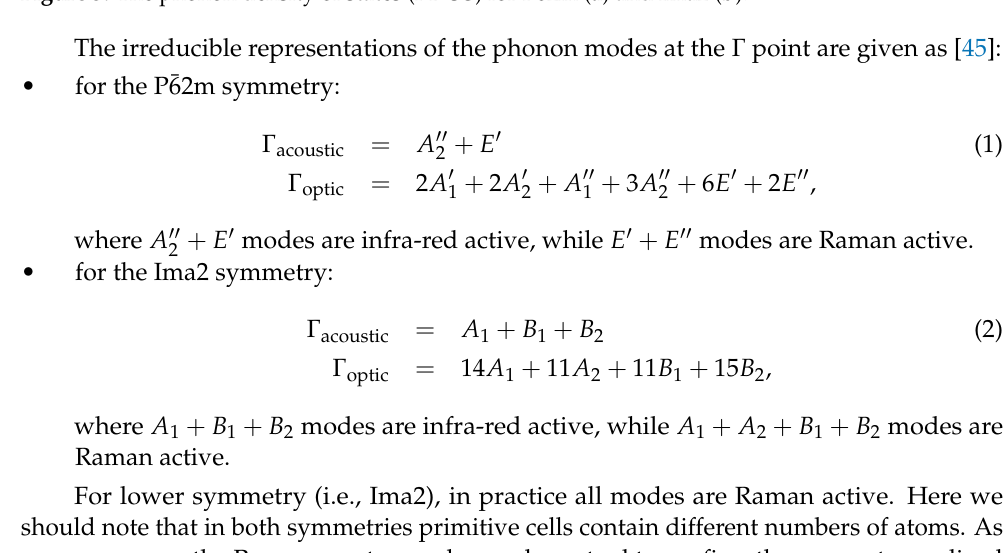
Figure 3. The phonon density of states (PDOS) for P¯62m ( a ) and Ima2 ( b